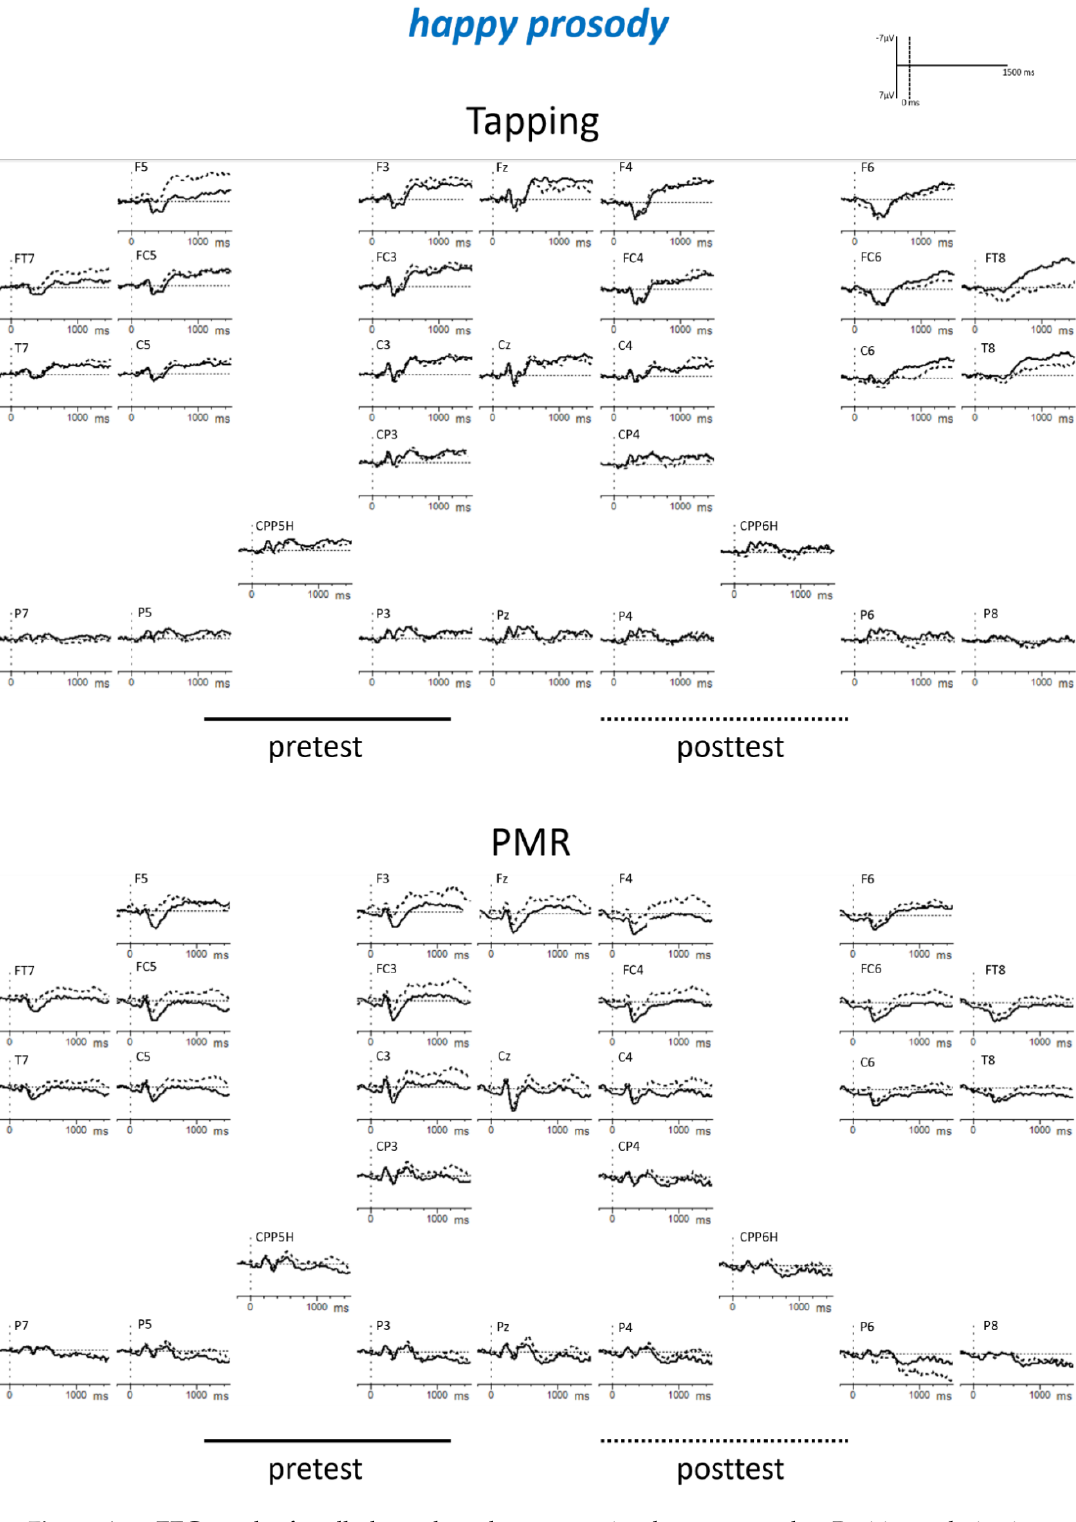
Figure A2. EEG results for all electrodes when processing happy prosody. Positive polarity is plotted downwards.